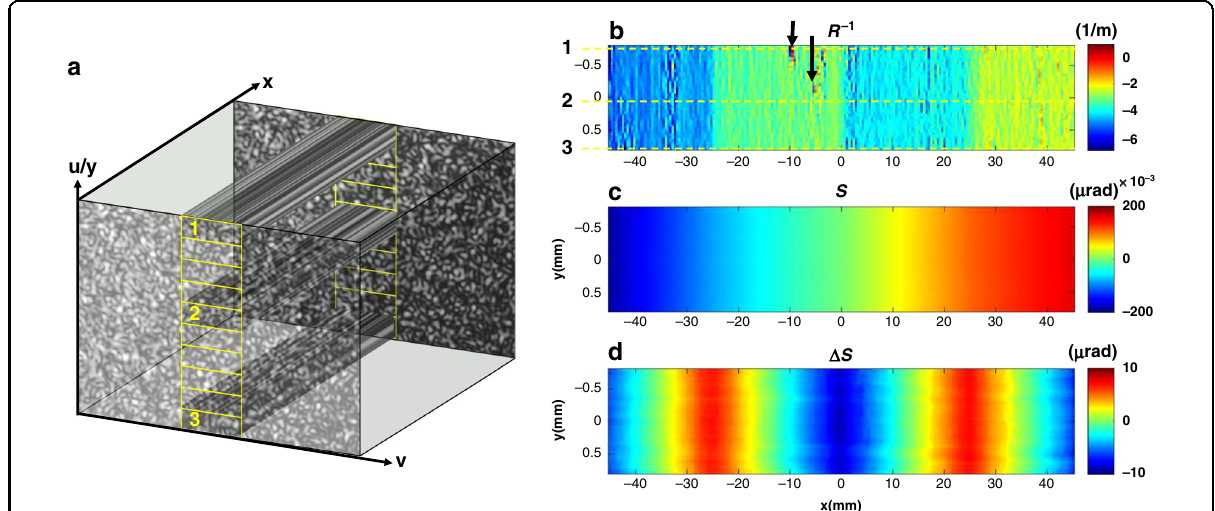
Fig. 7 Demonstration of generation of 2D maps of mirror surface. a Schematic representation of the generation of 2D maps of the modi fi ed elliptical mirror by choosing multiple subset windows along the camera width from a stack of speckle images. The measured 2D map for tangential ( b ) reciprocal local radius of curvature (R − 1 ), ( c ) slope ( S ), and ( d ) parabolic modi fi cation ( Δ S